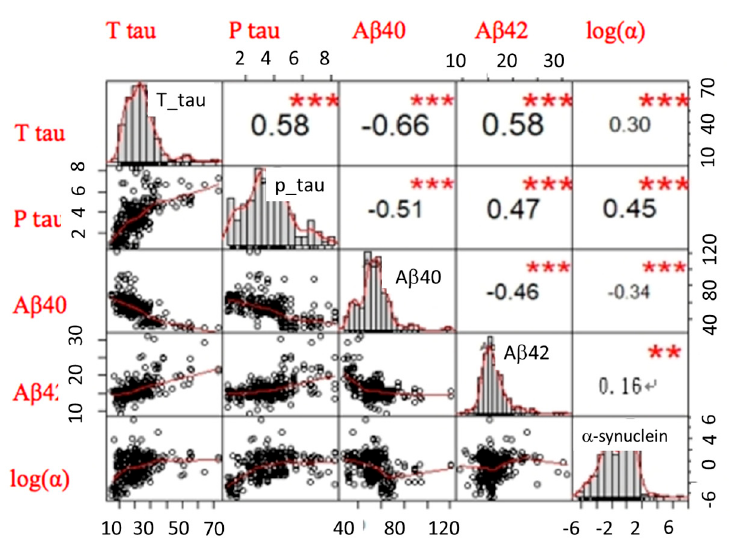
Figure 6. The correlation matrix between each biomarker from four groups, including normal controls, PD-NC, PD-MCI, and PDD. The lower triangular part of the matrix is the scattered-plot graphs of any two biomarkers. The main diagonal part of the matrix is the distribution graphs of each biomarker. log( α ) is the log of α -synuclein. ** p < 0.01; *** p < 0.001. The established 3-dimensional model was based on the linear discriminant function, as shown below, to illustrate the 3D scatter plot of the samples and classify the patients with normal controls, PD-NC, PD-MCI, and PDD (Figure 7).